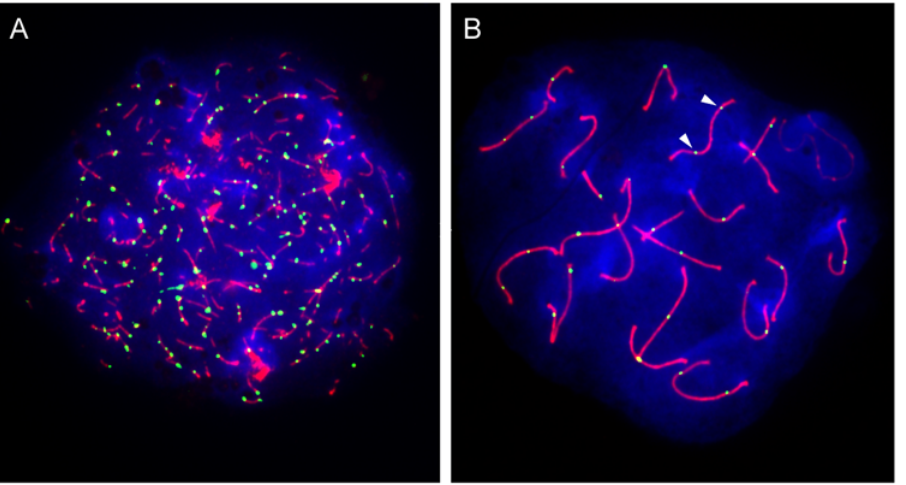
Figure 1. Only a subset of DSBs become crossovers. Mouse spermatocyte spreads were stained for the chromosomal axial element SYCP3 (red) and either (A) RAD51 (green) or (B) MLH1 (green). DAPI staining is shown in blue. Each DSB gives rise to a chromosome-associated RAD51 complex, whereas MLH1 complexes localize only to sites that will become crossovers. There is an approximate 9-fold excess of DSB-associated foci relative to crossover-associated foci. Arrowheads point to an example of an autosome with two widely separated MLH1 foci, characteristic of crossover interference. (Images courtesy of Ignasi Roig, Molecular Biology Program, Memorial Sloan-Kettering Cancer Center).